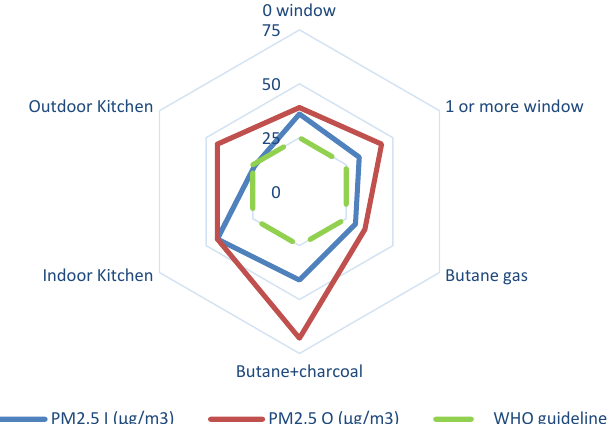
Fig. 2. Average concentration of indoor PM and outdoor PM are ranked on each of the 6 parameters and the line helps to visually 2.5 2.5 influence of each aspect over PM Fig. 2: Average concentration of indoor PM 2.5 and outdoor PM 2.5 are ranked on each of the 6 parameters and the line helps to visually influence of each aspect over PM 2.5 concentrations in site A compare to WHO guideline value (25 µg/m 3 )